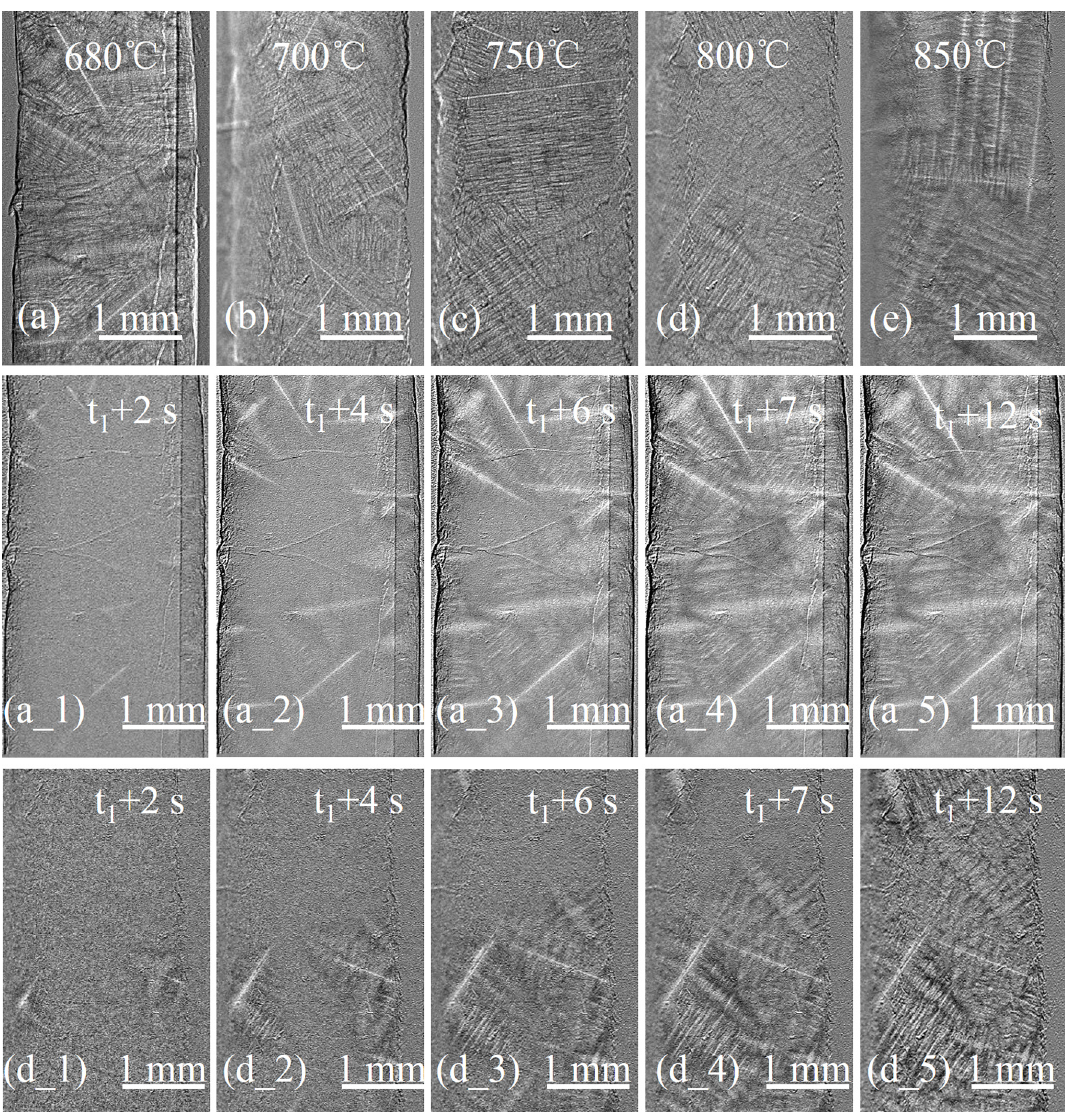
Figure 2. The microstructure of the 2 mm sample under different beginning